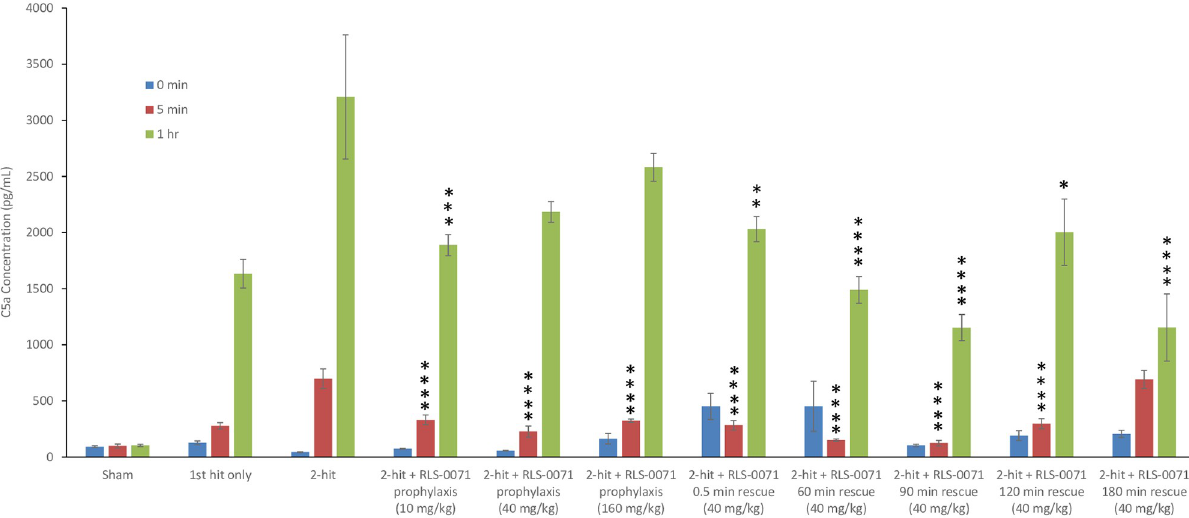
Fig 4. RLS-0071 inhibits complement activation. Plasma was isolated from sham animals (n = 3) and the following groups prior to first-hit (0 minutes) and at 5 minutes and 1 hour: first hit only (n = 3), 2-hit (n = 3), 2-hit + 10 mg/kg prophylactic dose RLS-0071 (n = 8), 2-hit + 40 mg/kg prophylactic dose RLS-0071 (n = 4), 2-hit + 160 mg/kg prophylactic dose RLS-0071 (n = 5), 2-hit + 40 mg/kg rescue dose RLS-0071 at 0.5 min (n = 5), 2-hit + 40 mg/kg rescue dose RLS-0071 at 60 min (n = 3), 2-hit + 40 mg/kg rescue dose RLS-0071 at 90 min (n = 5), 2-hit + 40 mg/kg rescue dose RLS- 0071 at 120 min (n = 3) and 2-hit + 40 mg/kg rescue dose RLS-0071 at 180 min (n = 3). C5a was then measured in each sample by ELISA and absorbance was read at 450 nm. Two replicates for each animal were measured for every time point. Data are means and standard error of the mean. Statistical analysis was performed using were conducted using bootstrap approach or Welch’s ANOVA. � denotes p = 0.010, �� denotes p = 0.004, ��� denotes p = 0.002, and ���� denotes p � 0.001 compared to 2-hit animals.